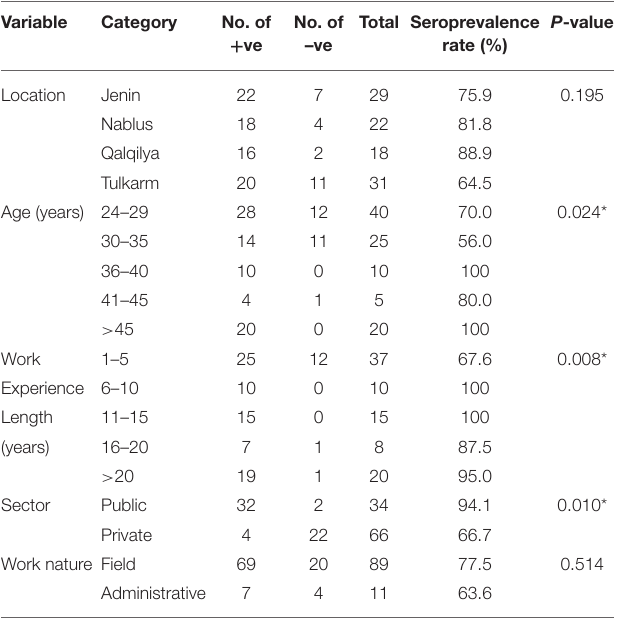
TABLE 1 | Results of the indirect-ELISA brucellosis test for occupational risk factors for veterinarians working in veterinary healthcare in the Northern Palestine. Variable